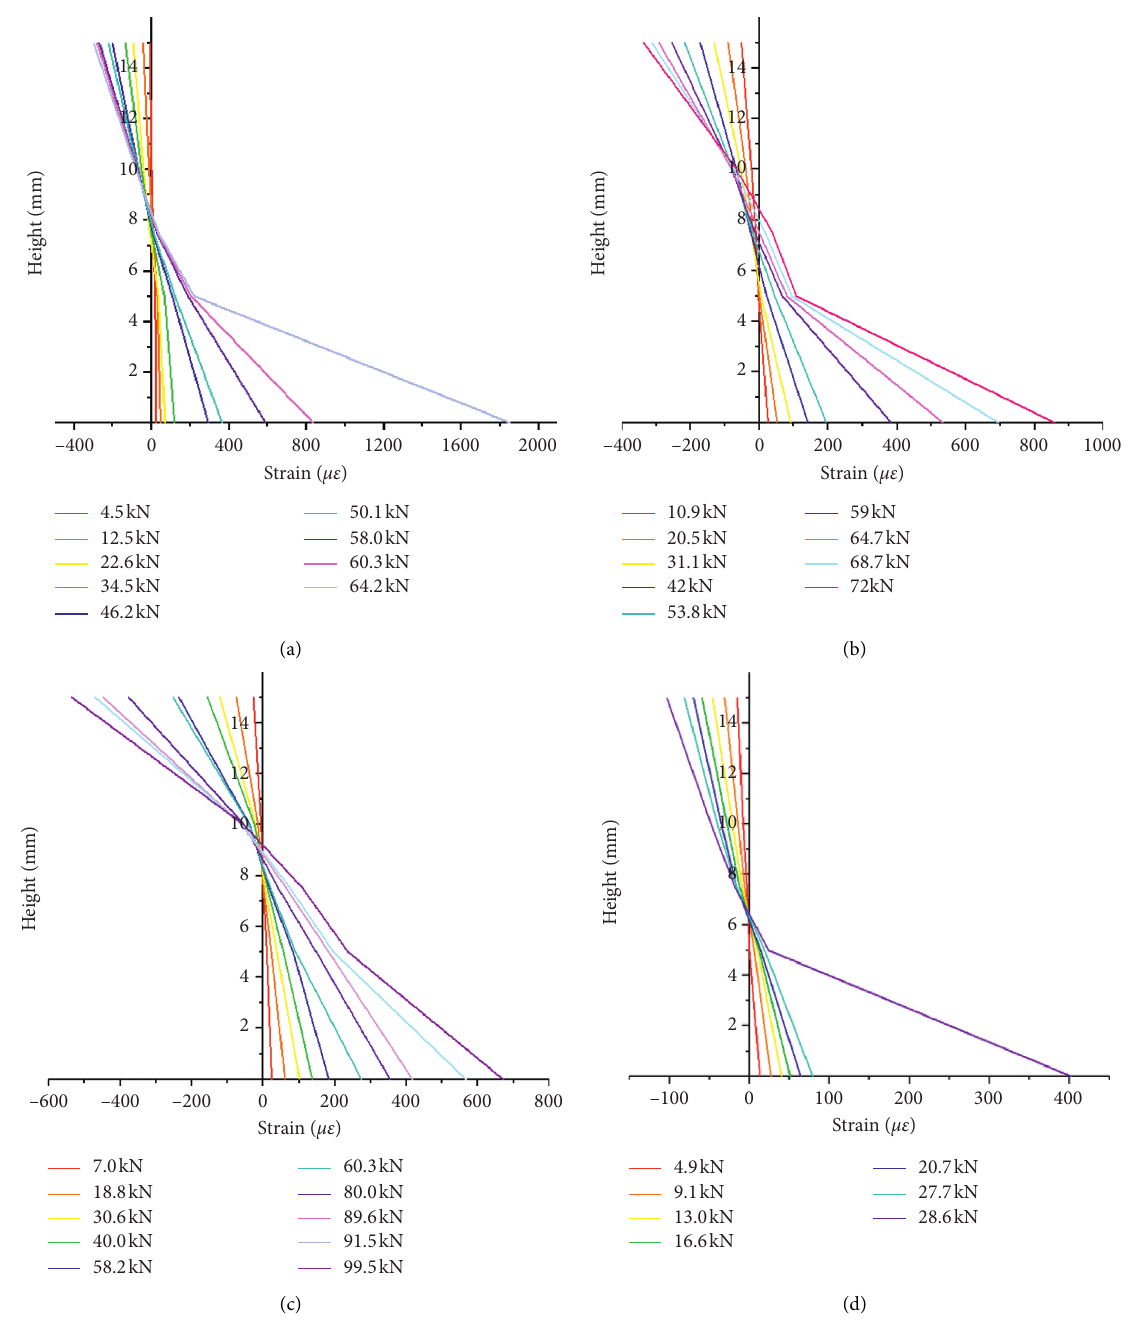
Figure 17: Strain distributions for tested composite decks. (a) Specimen U50. (b) Specimen U60. (c) Specimen U70. (d) Specimen